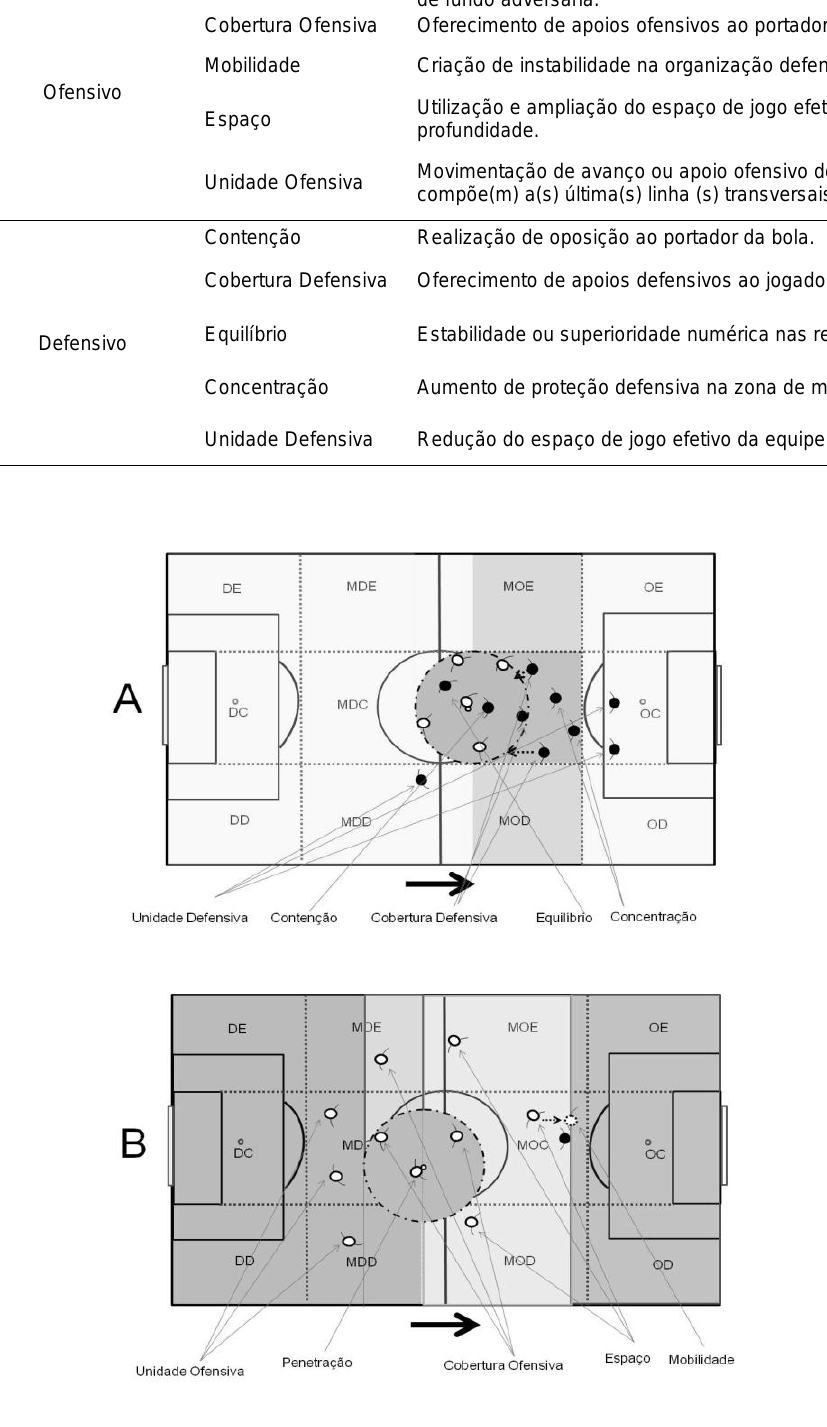
Figura 1. Princípios Táticos Fundamentais do jogo de Futebol em função das fases (A - defensiva e B - ofensiva) e da gestão do espaço de